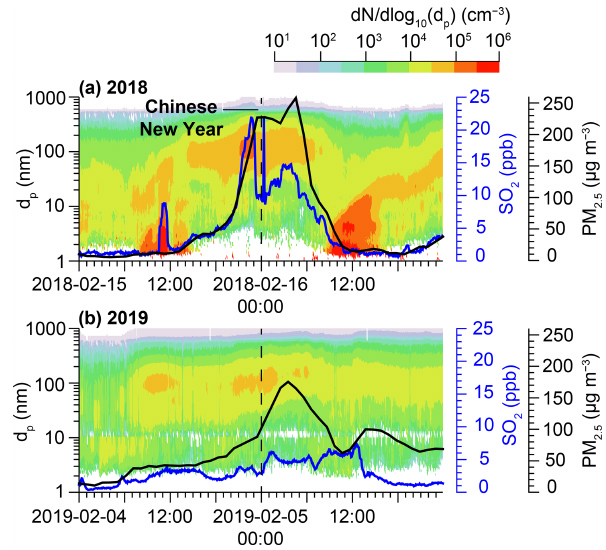
Figure 5. Aerosol particle number size distribution (PSD) from 1d before the CNY through 1d following the CNY in 2018 and 2019, overlain with aerosol mass concentration PM 2 . 5 (black lines) and SO 2 (blue